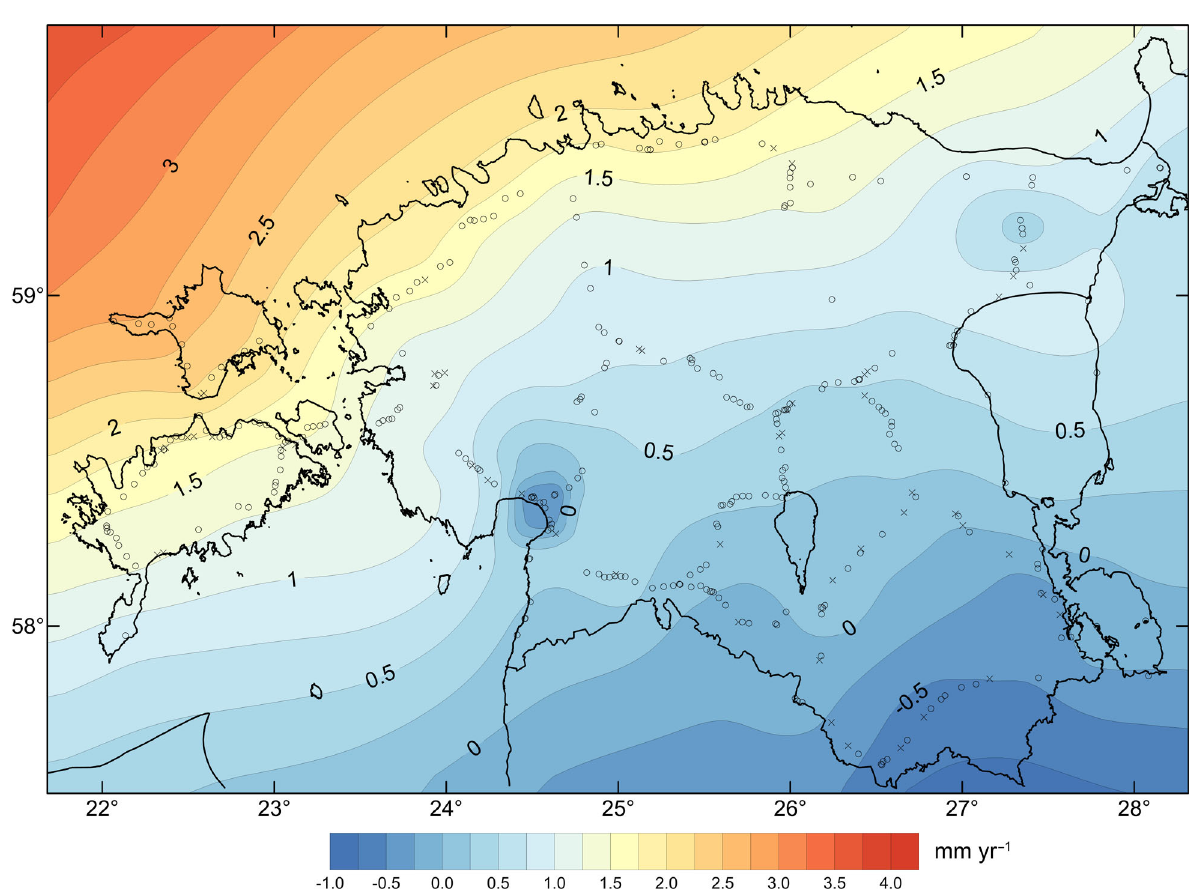
Fig. 4. The model of vertical crustal movements EST2015LU based on 283 apparent vertical velocities (VVs) of the benchmarks (BMs) from the kinematic adjustment of the second, third and fourth levellings of the common levelling network (Fig. 1) relative to BM FR241 in Tallinn with the apparent VV of + 1.7 mm yr –1 . The apparent VVs of 12 water gauges (WGs) of Lake Peipsi (Table 6) were also used. The contour interval is 0.25 mm yr –1 . Average standard errors of the VVs were  0.12 mm yr –1 (BMs) and  0.01 mm yr –1 (WGs). Statistics of model residuals were min – 3.07 mm yr –1 (BM in Pärnu), max + 0.95 mm yr –1 (also BM in Pärnu), mean – 0.06 mm yr –1 and root mean square (RMS)  0.34 mm yr –1 . The model’s cross-validation residual RMS error was  0.30 mm yr –1 . The circles indicate the location of BMs and WGs used in the modelling (a total of 295); crosses (x) indicate the location of BMs visually removed before modelling